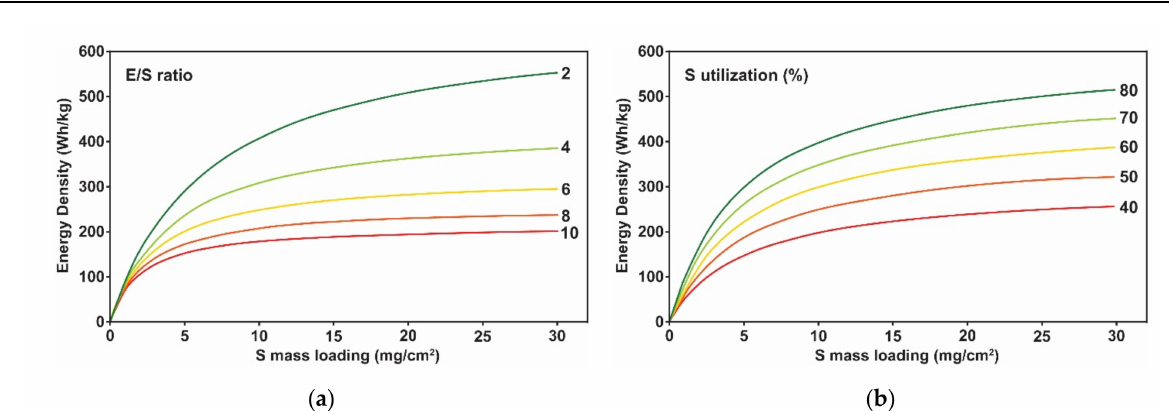
Figure 4. Design calculation of Lithium-Sulfur (Li/S) pouch cell specific energy ( a ) Obtainable specific energy for various sulfur mass loading and electrolyte/sulfur (E/S) ratios. Sulfur content and sulfur utilization were fixed to 80% and 70%, respectively. ( b ) Obtainable specific energy for various sulfur loading and sulfur utilization. E/S ratio and sulfur content were fixed to 3 and 80%,